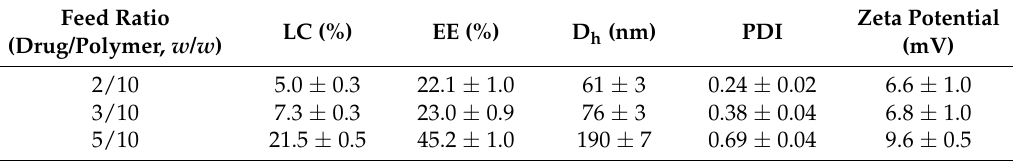
Table 1. Characteristics of DOX-NPs with different drug/polymer feed ratios.